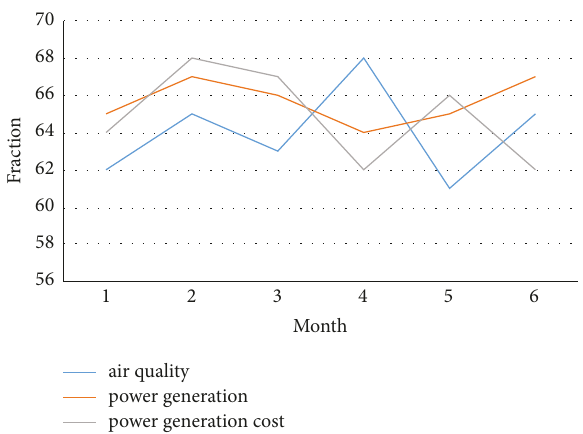
Figure 7: Changes in monthly air quality, power generation, and power generation costs in region B.